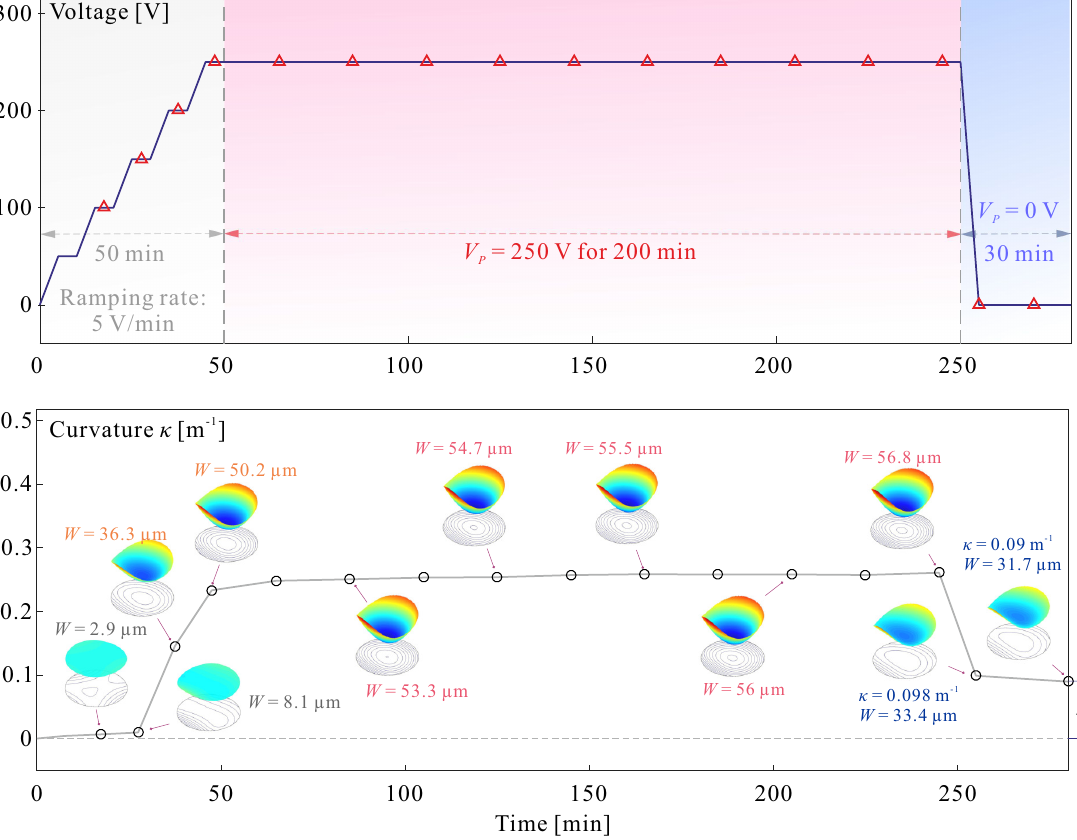
Figure 10. Time-history of the poling process of the sample of Figure 8. ( Top ): voltage history. ( Bottom ): relative surface figure deformation within the pupil (deflection W and curvature κ ). The final curvature residual estimate is κ R = 0.09 m − 1